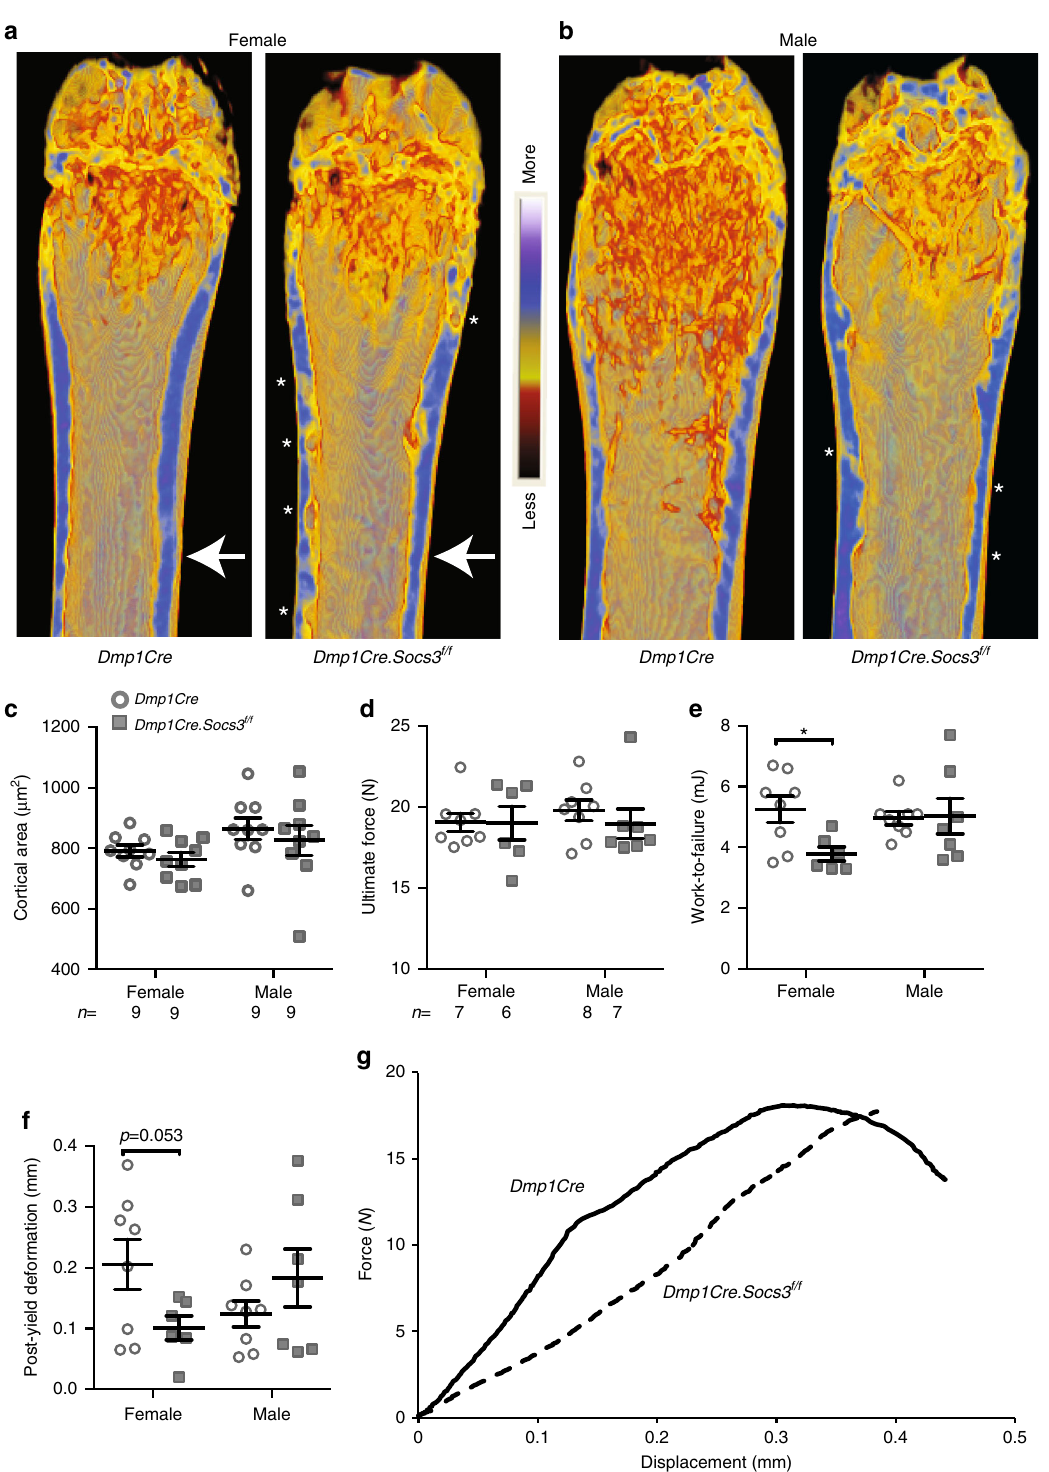
Fig. 4 Sex-speci fi c delay in corticalization in female Dmp1Cre.Socs3f/f mice leads to reduced bone strength at 26 weeks of age. a , b Representative coronal cross sections of female ( a ) and male ( b ) femora showing levels of mineralization (scale at the center of the images shows red = less mineralized, while blue = more mineralized); arrows indicate approximate location of load during 3 point-bending; asterisks alongside cortical bone denote regions of poor cortical consolidation. c Cortical bone area in 26-week-old male and female Dmp1Cre ( open circles ) and Dmp1Cre.Socs3 f/f ( gray squares ) femora; values are mean ± SEM, n is shown below the graph. d – f Results of 3 point-bending tests of femora from 26-week-old male and female Dmp1Cre ( open circles ) and Dmp1Cre.Socs3 f/f ( gray squares ) femora; values are mean ± SEM, n is shown below graph ( d ). * p < 0.05; ** p < 0.01 vs Dmp1Cre of the same sex by two-way ANOVA with Sidak post-hoc test. g Representative load-displacement curves of female Dmp1Cre ( solid line ) and Dmp1Cre.Socs3 f/f ( dashed line )